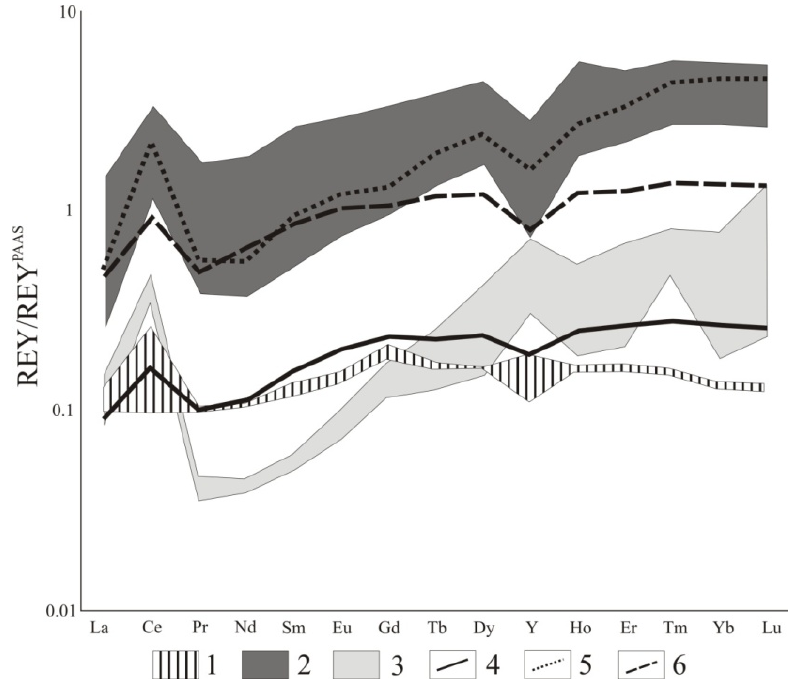
Figure 10. Shale-normalized (PAAS after [47]) REY patterns of Fe-Mn deposits of differing genesis in fraction III (legend see in Figure 7).